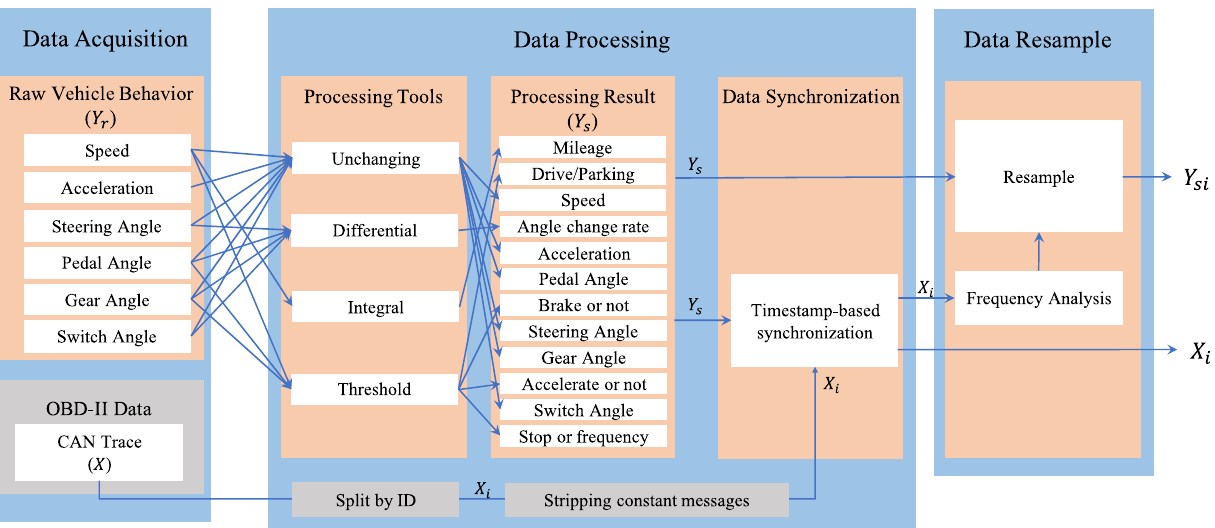
Table 2. Sensor locations and associated physical value.